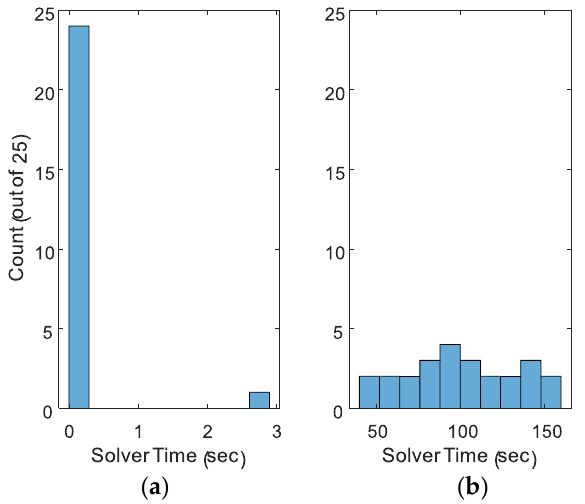
Figure 8. Histogram of SOH solution time for the small ( a ) and the large ( b ) problems.